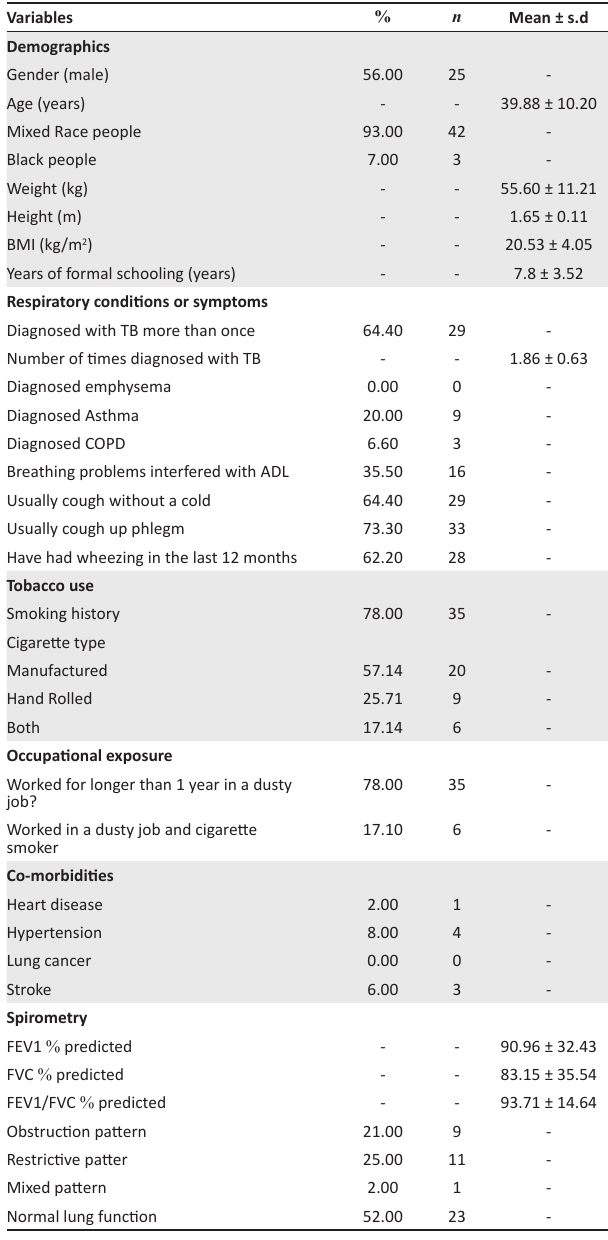
TABLE 1: Descriptive characteristics of population ( n = 45